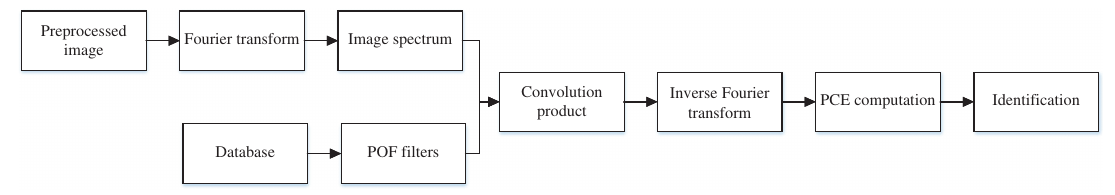
Figure 6: VLC Face Recognition System.